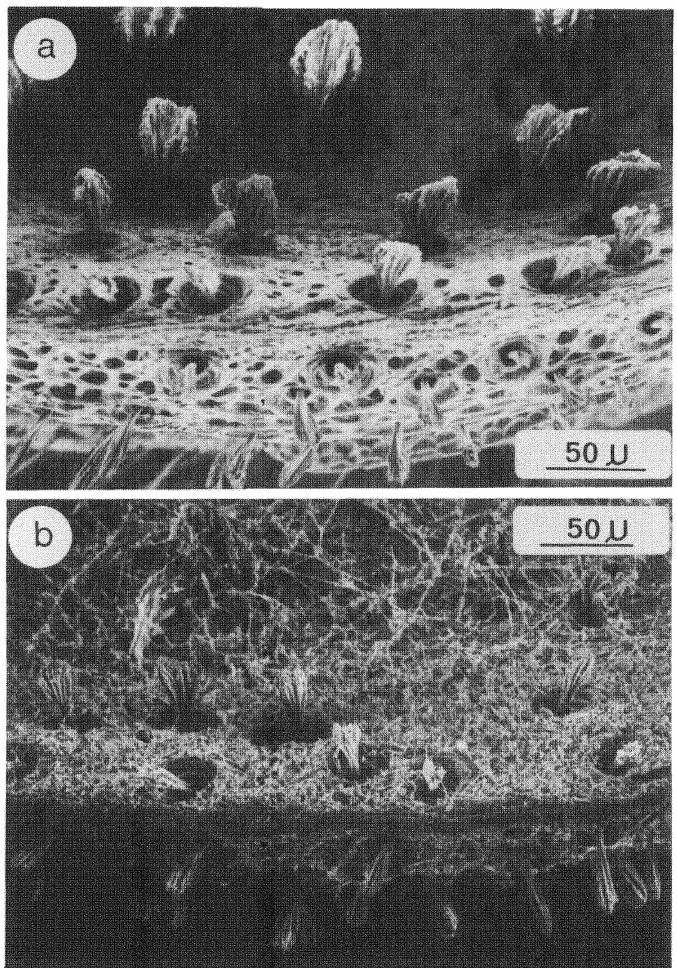
Fig. 8. Z. pallens porrasi. Views from rim of cephalic shield, a. (same individual as Fig. 7). Clean surface, b. Z. pallens porrasL second soldier, nestmate of individual in Fig. 8a. Shield is so matted that setae beyond the second row are completely